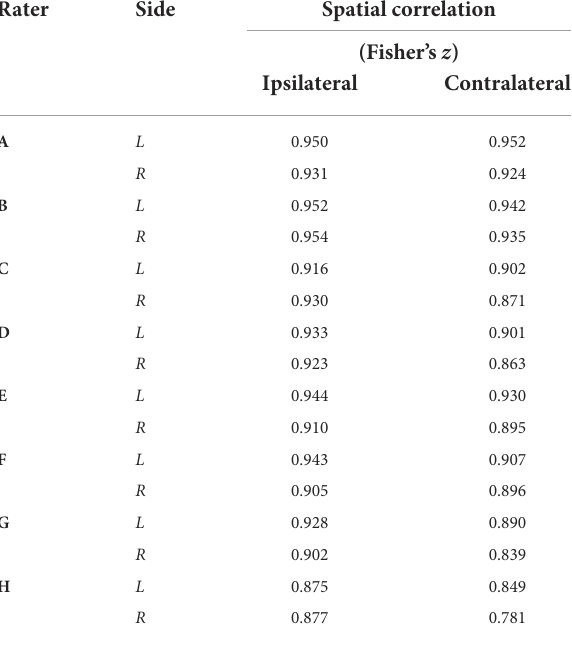
TABLE 4 Group–level activation map spatial correlations (Fisher’s z) between each rater and the reference by side [left (L) or right (R)] and stimuli condition (ipsilateral or contralateral